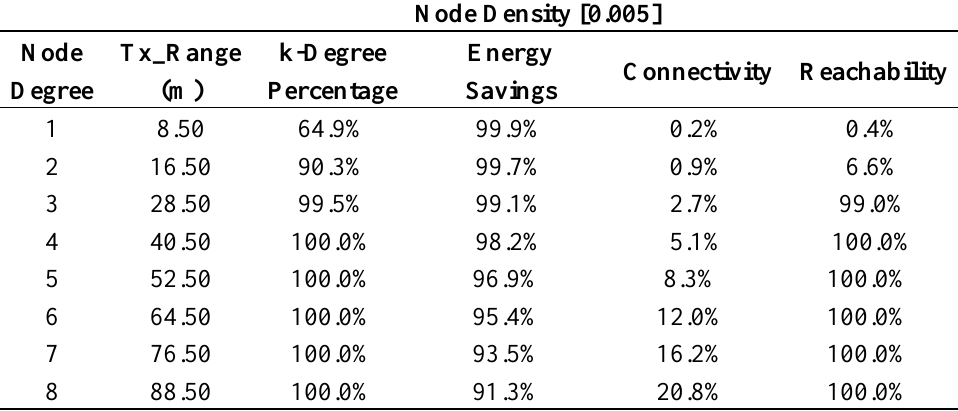
Table 3. The numerical evaluation results for a network with a node density of 0.005 nodes/m 2 .